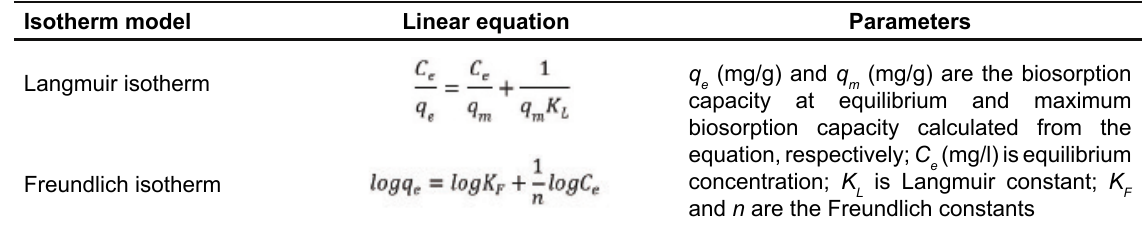
Table 2. Linear equations of Isotherm models